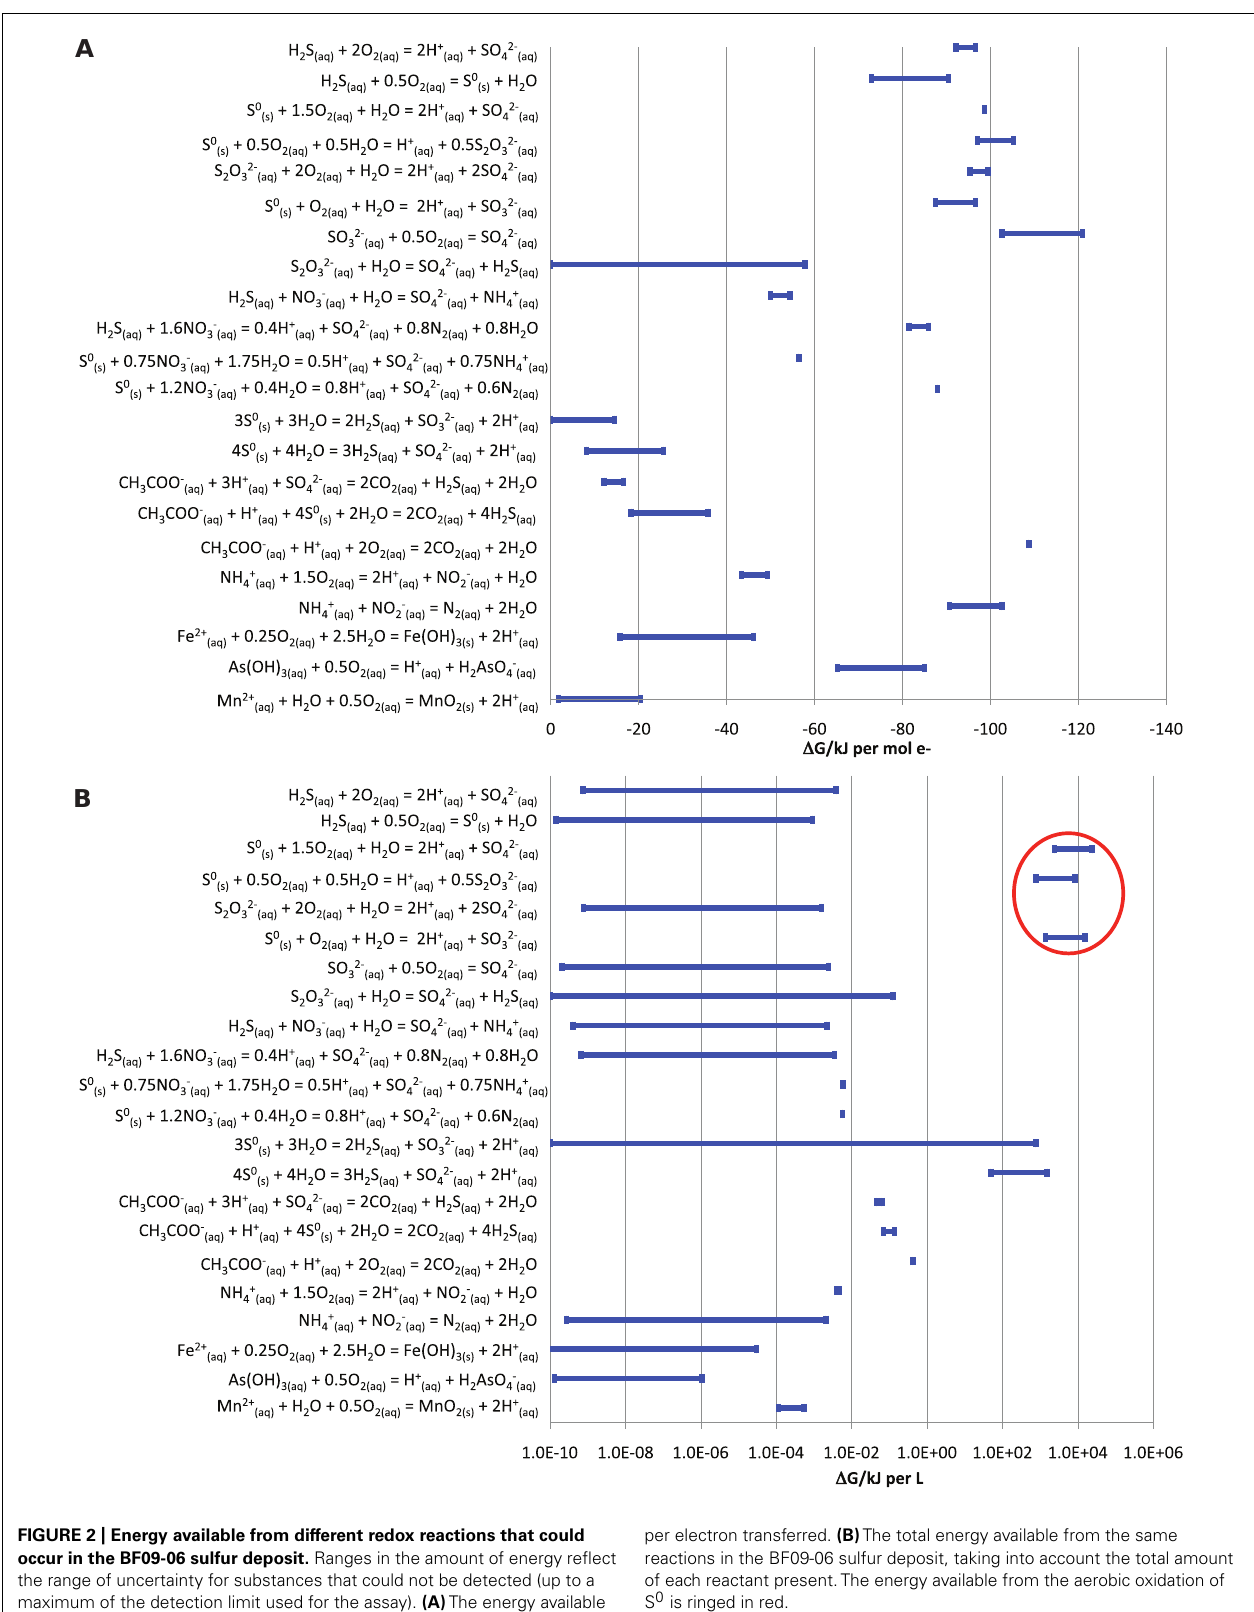
per electron transferred. (B) The total energy available from the same reactions in the BF09-06 sulfur deposit, taking into account the total amount of each reactant present.The energy available from the aerobic oxidation of S 0 is ringed in